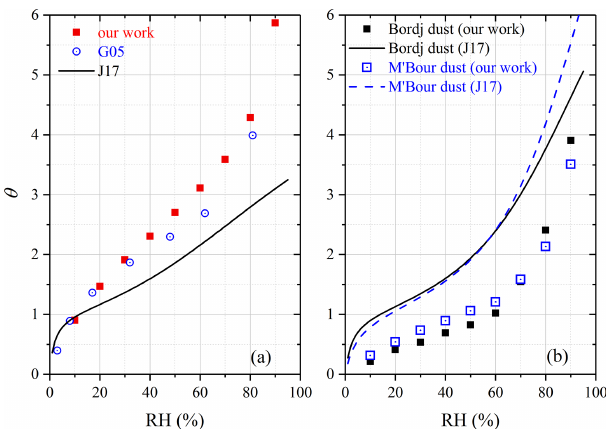
Figure 9. (a) Comparison of mass ratios of adsorbed water to the dry mineral ( m w /m 0 ) measured by our work and N10 (Navea et al., 2010) for Saharan dust. (b) Comparison of surface coverages of adsorbed water ( θ ) for TLF dust measured in our work with Beijing dust measured in M12 (Ma et al., 2012b). Saharan dust was studied using QCM (Navea et al.,